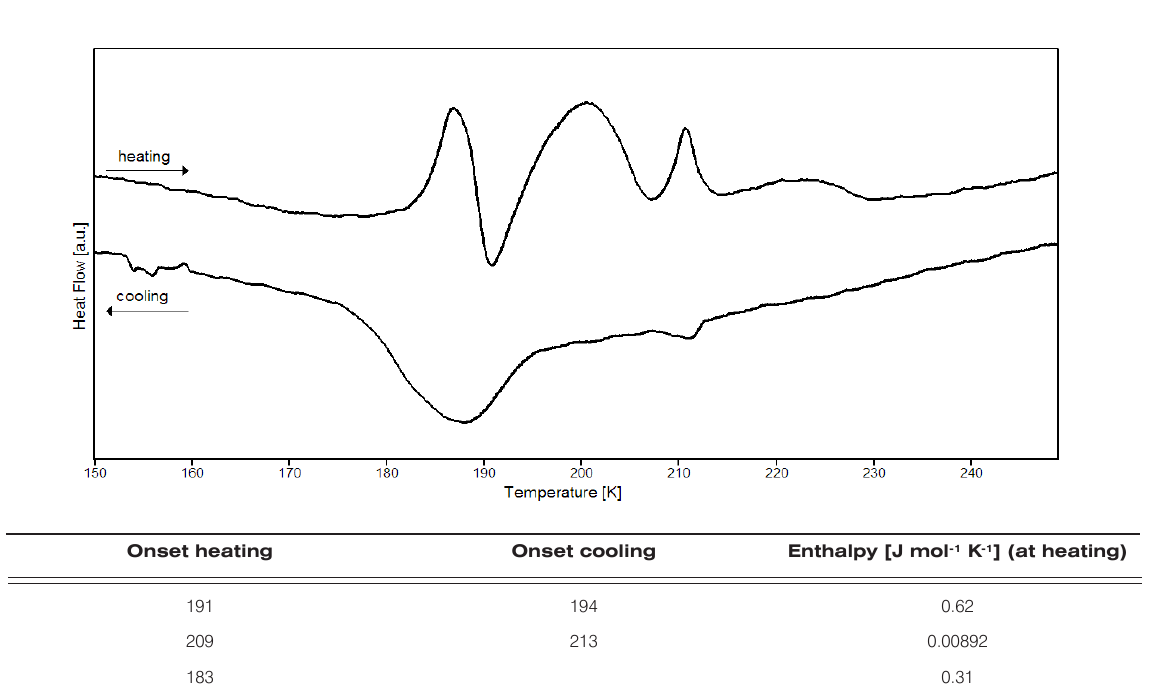
Figure 1. The DSC diagram for L-leucine*perchlorate acid